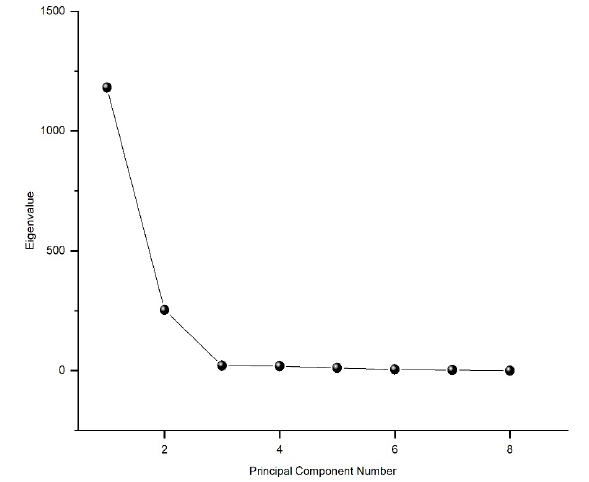
Figure 3: Plot of eigenvalues for PCA of FTIR spectra.